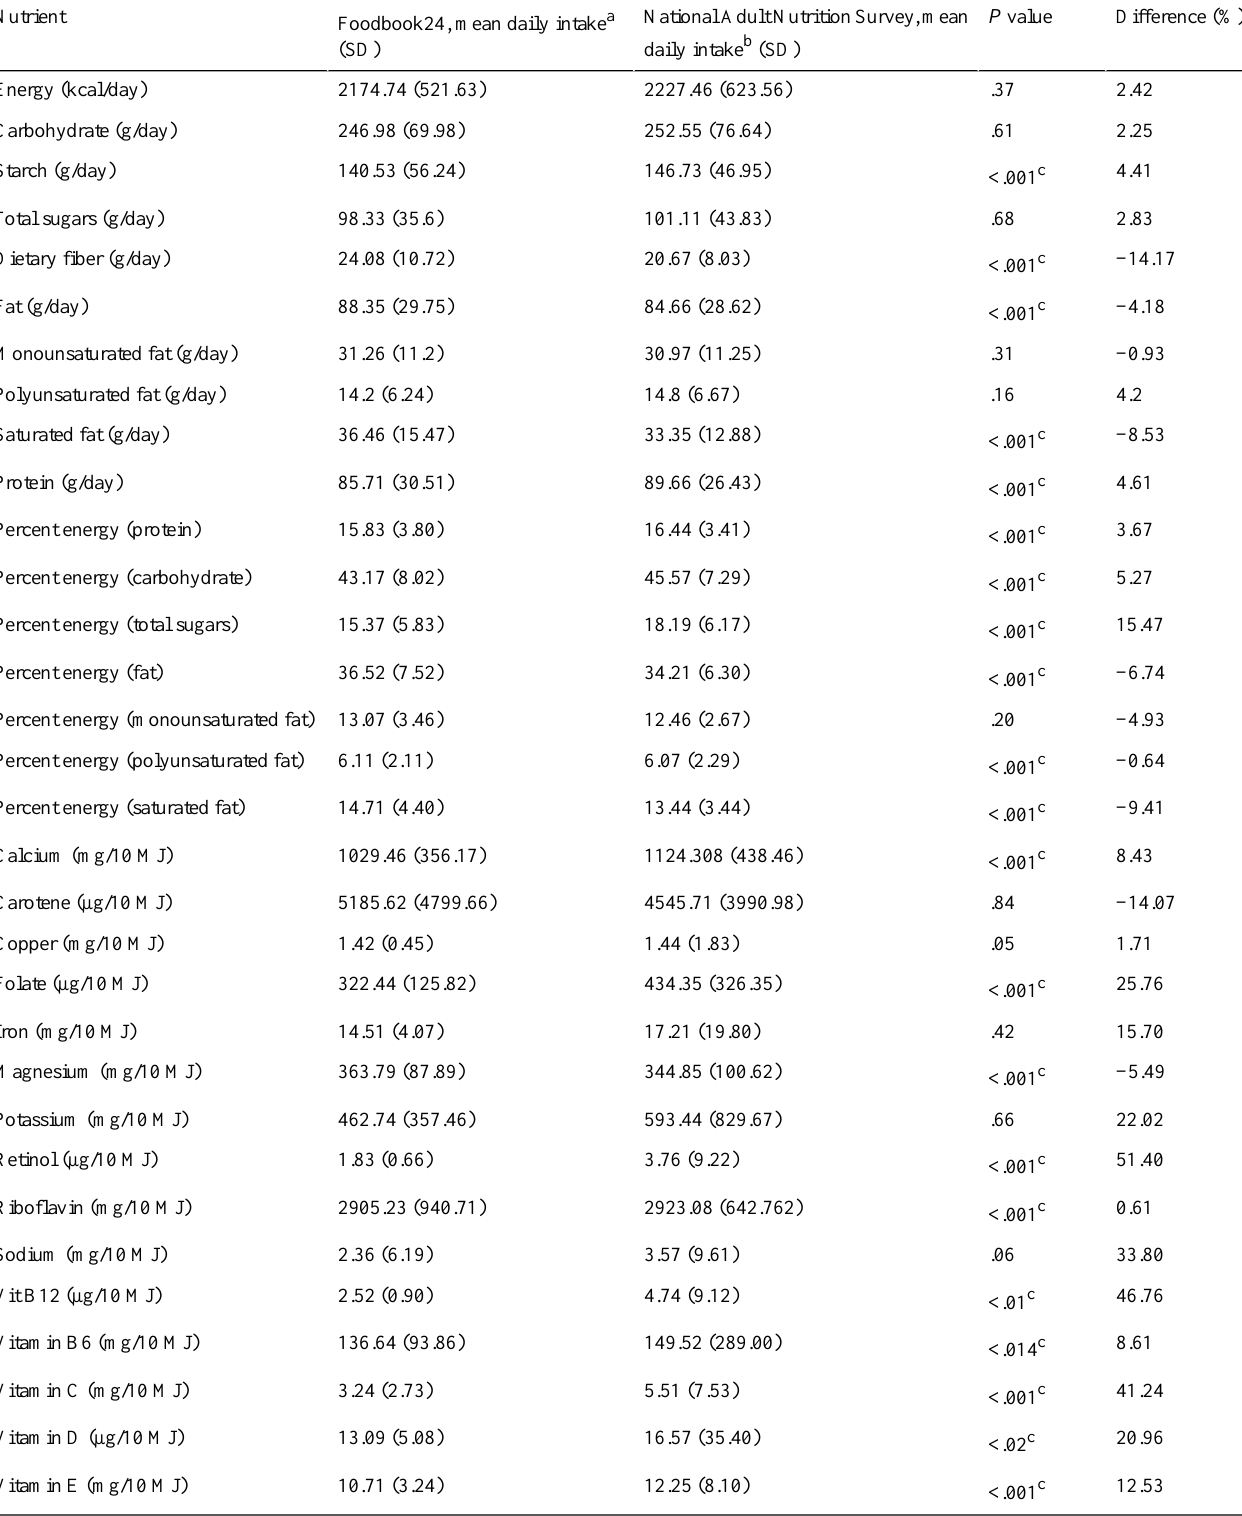
Table 2. Nutrient intake of adequate reporters from the Foodbook24 web-based study (2016) and the National Adult Nutrition Survey (2011).